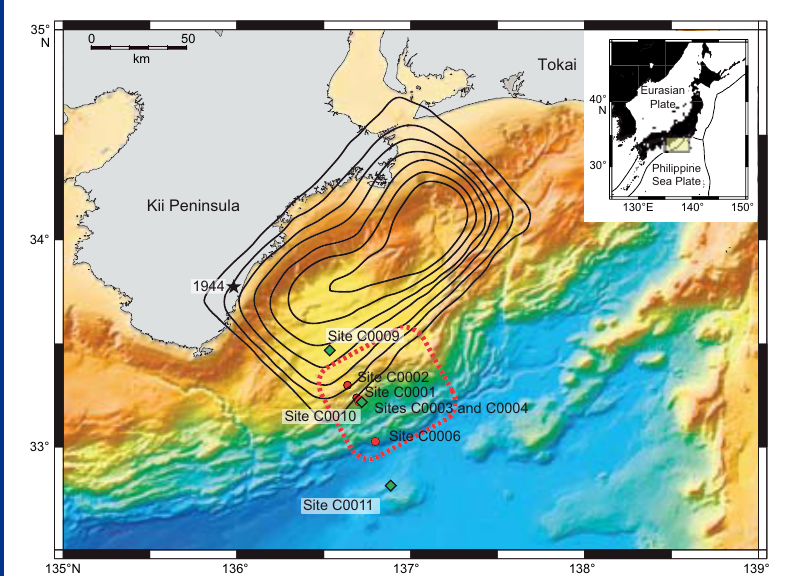
Figure 1. Map of the Nankai margin study area showing drill sites (from Stage 1 and from this expedition, including Site C0011 of Expedition 322; Underwood et al., 2010), details of 1944 plate boundary earthquake slip, and location of coseismic VLFs. See Fig. 6 and Saffer et al. (2009, 2010) for further geographic information. Contours = estimated slip from 1944 event (0.5 m intervals, increasing inwards; Kikuchi et al., 2003), red box = region of recorded VLFs (Obara and Ito, 2005). Inset shows tectonic